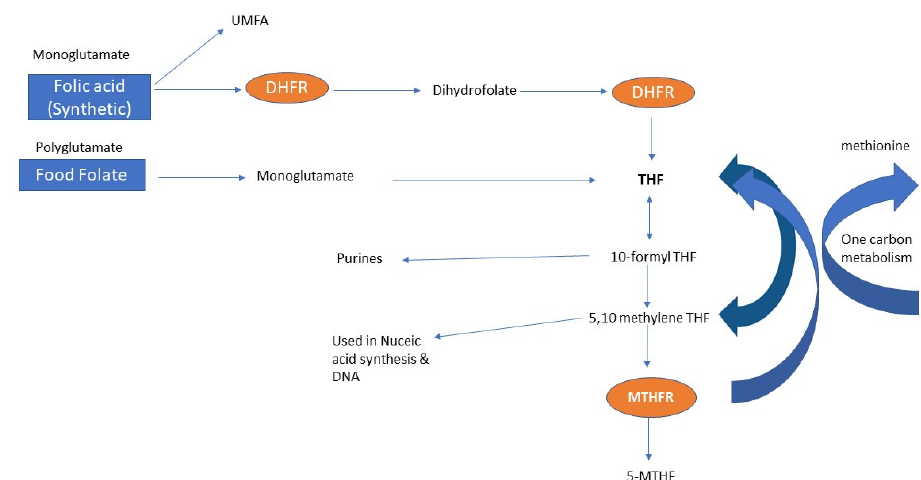
Figure 5. Folate metabolism leading to one carbon metabolism—the end goal is for folates to be metabolized to 5-MTHF, where it is used by methionine synthase reductase (MTR) for one carbon metabolism and methylation reactions: 5-MTHF = 5-methyltetrahydrofolate reductase, DHFR = dihydrofolate reductase, THF = tetrahydrofolate, MTHFR: methylenetetrahydrofolate reductase, and UMFA: unmetabolized folic acid.